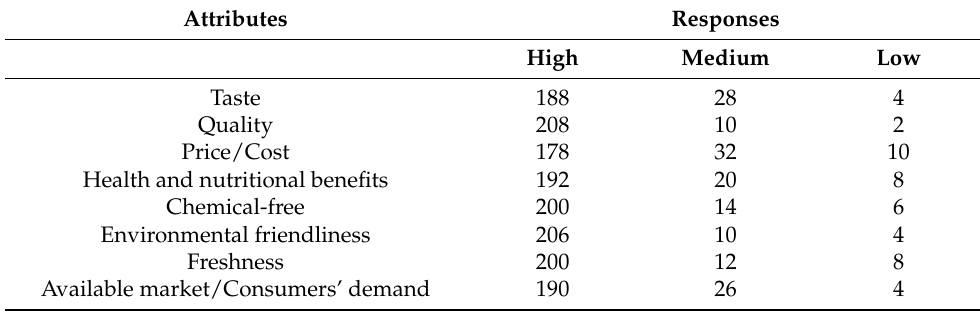
Table 6. Perceptions of organic produce by farmers (Certified, Transitional and